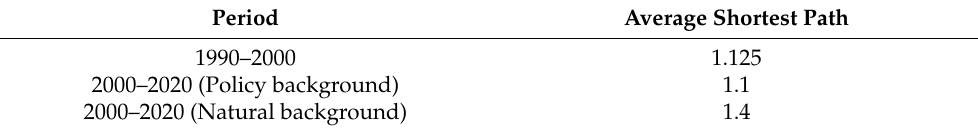
Table 9. Average shortest path and average node degree in different periods.